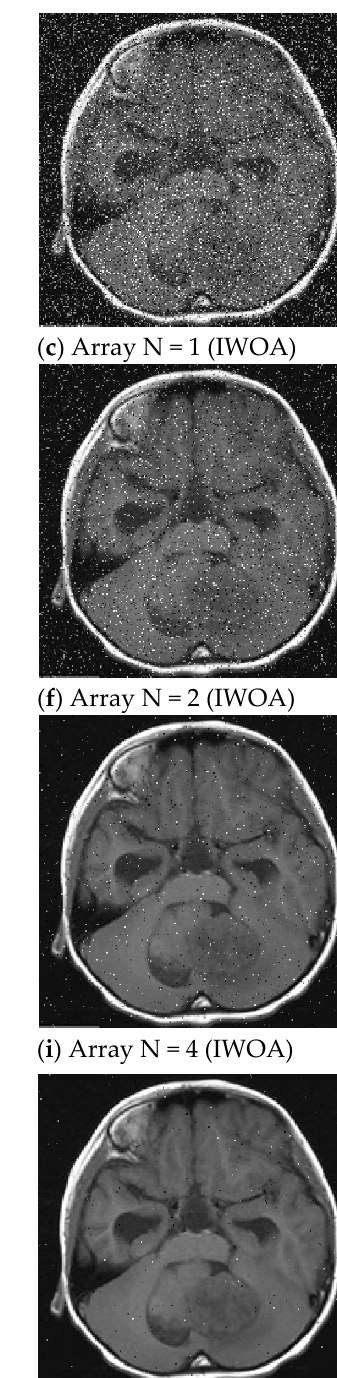
( f ) Gaussian filtering Figure 8. MRI image enhancement for four classical filtering methods. Table 5. MRI image under four classical filtering algorithms for PSNR (dB). Image Name